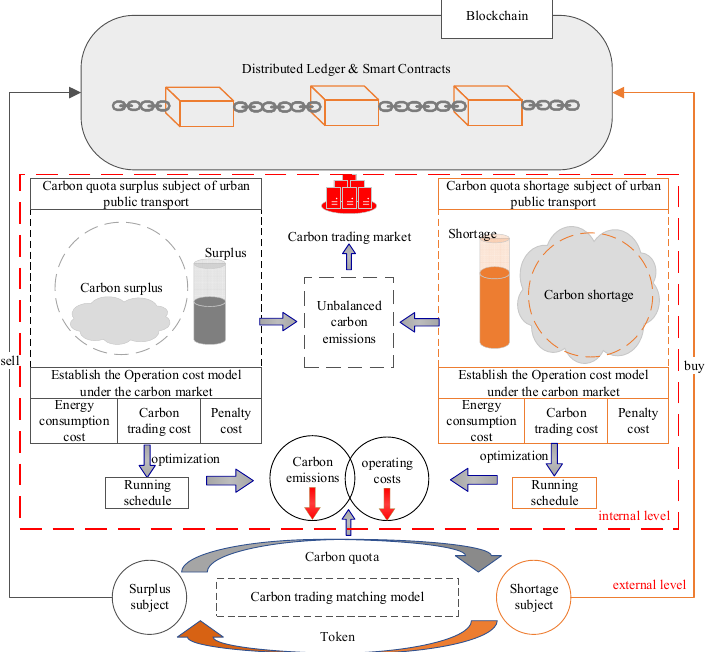
Figure 1. Architecture of urban public transport carbon-trading system based on blockchain technology.